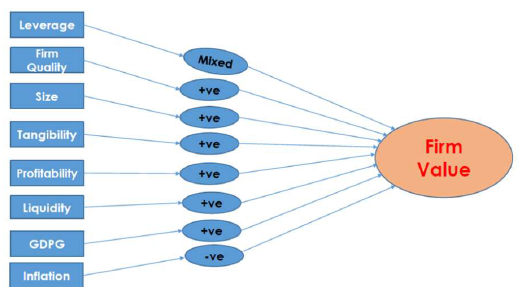
Fig. 1. Linkage of Firm attribute, Quality and Leverage on Firm